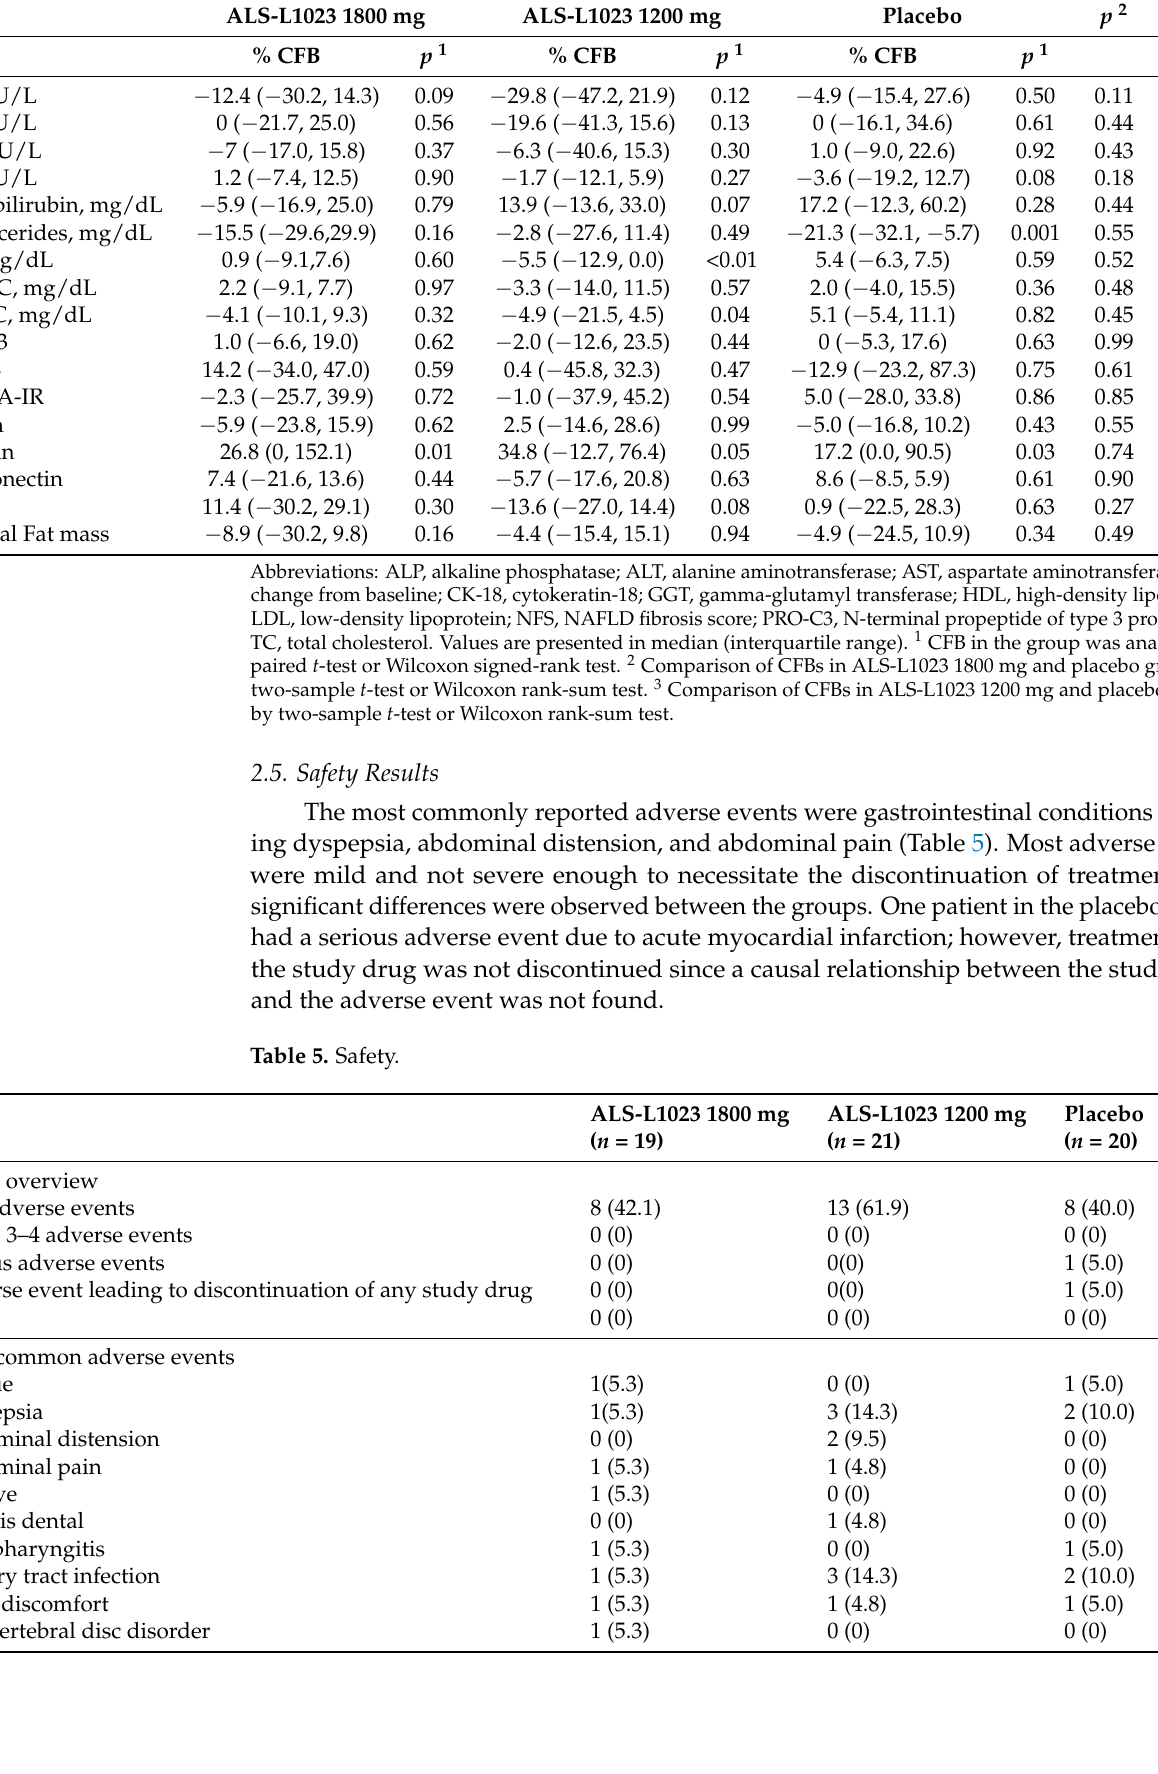
Table 4. Change in serum biomarkers from baseline to week 24 in the